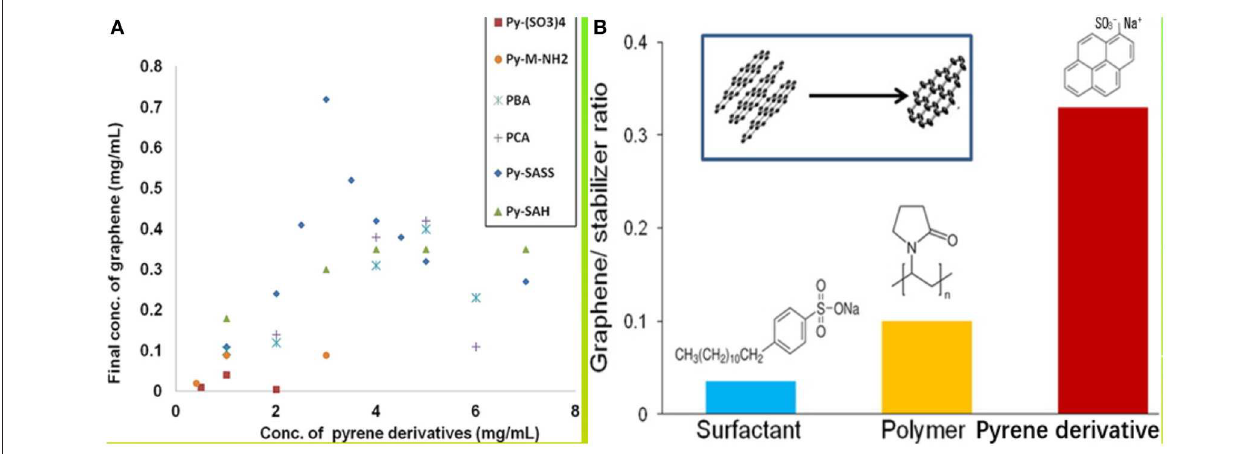
FIGURE 6 | (A) Dispersion of graphene by each pyrene derivative. (B) Dispersion of graphene by different negatively charged dispersants.